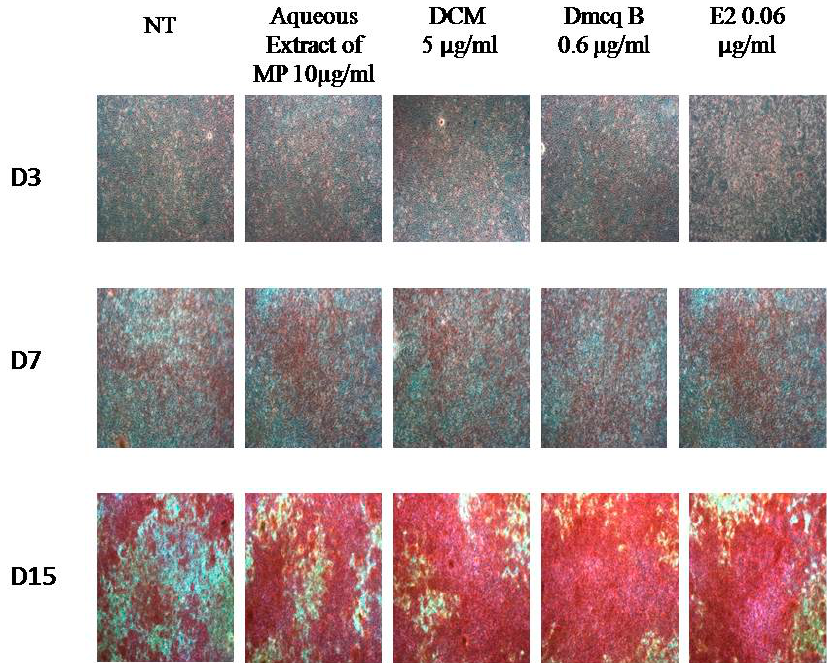
Figure 4. Effects of M. pumilum var. alata crude aqueous extract, DCM fraction, Dmcq B and E2 (positive control) on collagen synthesis during 15 days of differentiation induction. The photomicrographs